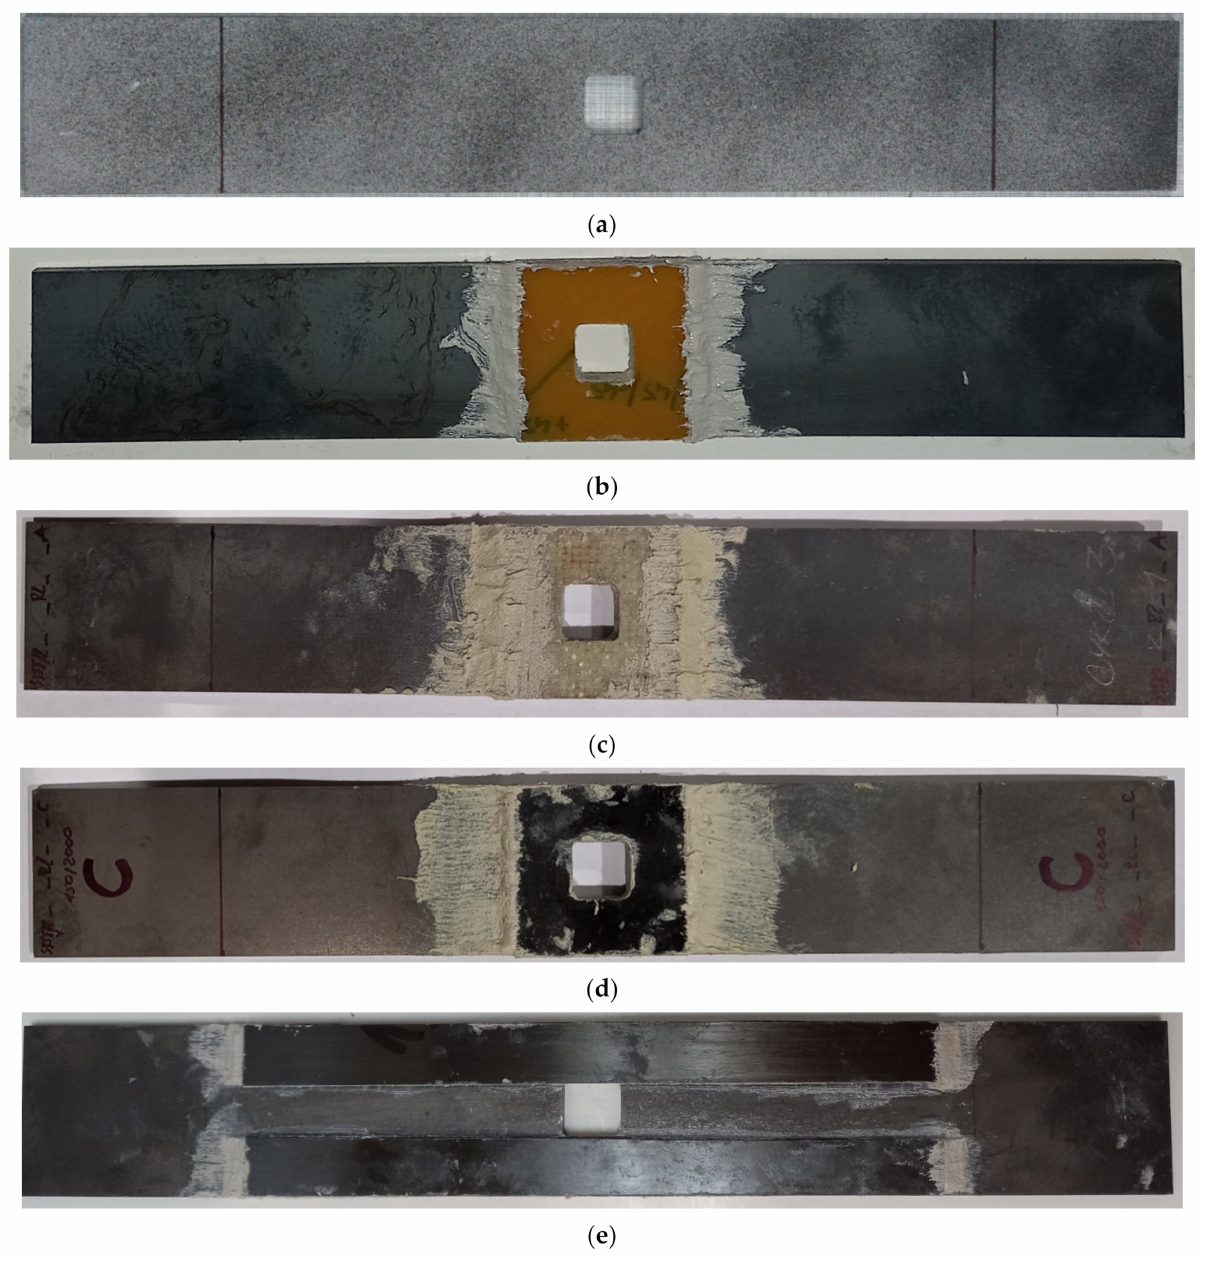
Figure 4. Notched samples with composite overlays: ( a ) sample no. 16 without overlays; ( b ) sample no. 19—Hexcel TVR 380 [+45 ◦ / − 45 ◦ ] 4 ; ( c ) sample no. 20—E-glass woven roving; ( d ) sam- ple no. 21—S&P C-Laminate 150/2000—45 × 45 mm; ( e ) sample no. 22—S&P C-Laminate 150/2000—15 × 180